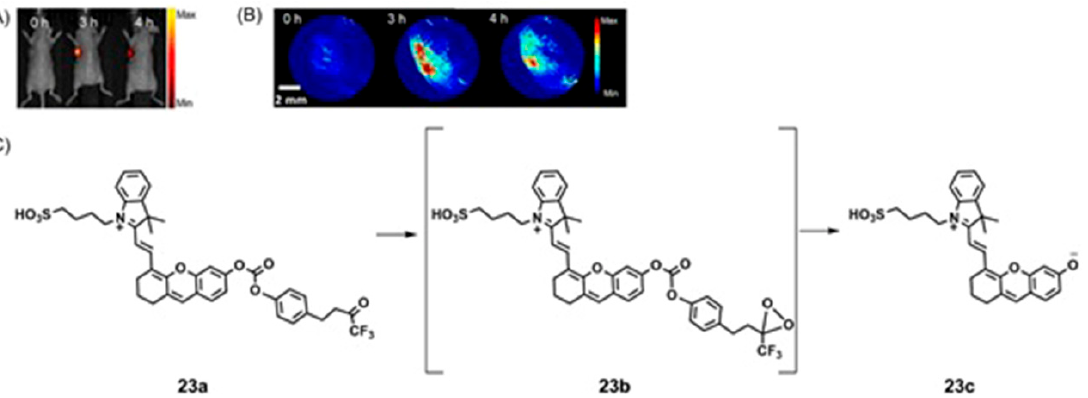
Figure 46. In vivo studies of the molecular probe 23 . ( A ) Real-time fluorescence images of tumor- bearing mouse after systemic administration of 23a (50 μ M in 100 μ L saline) at 0, 3, and 4 h. ( B ) Representative photoacoustic maximum imaging projection of tumor from a systemic administra- tion of a living mouse at 0, 3, and 4 h post-injection of 23a (50 μ M in 100 μ L saline). ( C ) Chemical structures of 23a , 23b , and 23c , and the conversion of 23a to 23c . Adapted with permission from Zhang, J.; Zhen, X.; Zeng, J.; Pu, K. A dual-modal molecular probe for near-infrared fluorescence and photoacoustic imaging of peroxynitrite. Anal. Chem. , 2018 , 90 , 9301–9307. Copyright 2018 American Chemical Society